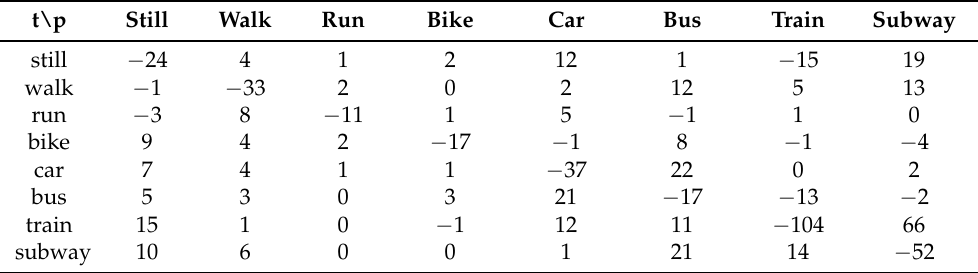
Table 6. The difference confusion matrix of the network trained without the gyroscope. The largest loss in classification occurred in the class subway and the smallest in class run . t = true label, p = predicted